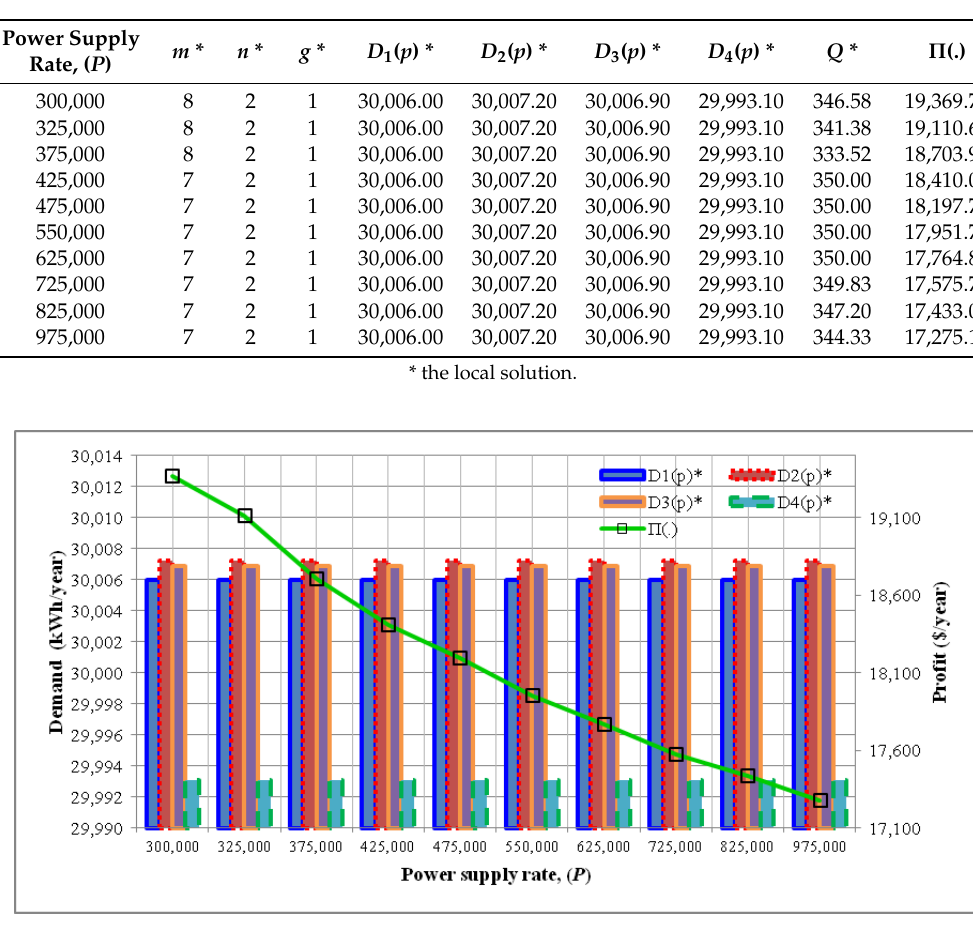
Figure 6. The Effect of Changes in the Power Supply Rate on Profitand Demand.